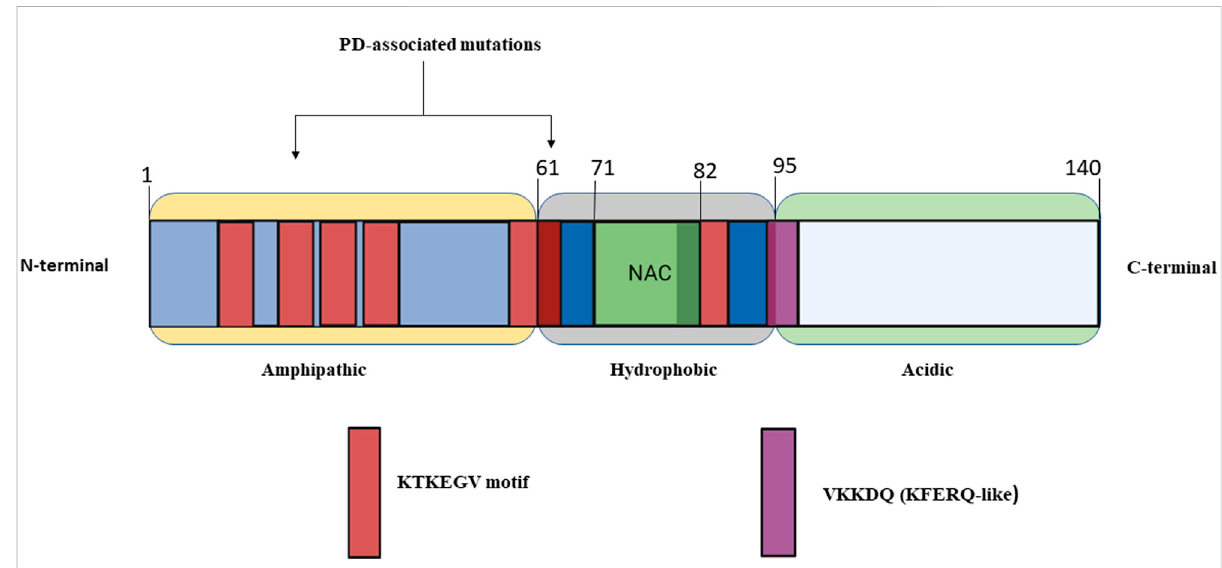
FIGURE 1 Simpli fi ed structure of alpha-synuclein made up of 140 amino acid residues and broadly categorized into three major regions of α -Syn (1) Amphipathic (2) Hydrophobic (3)